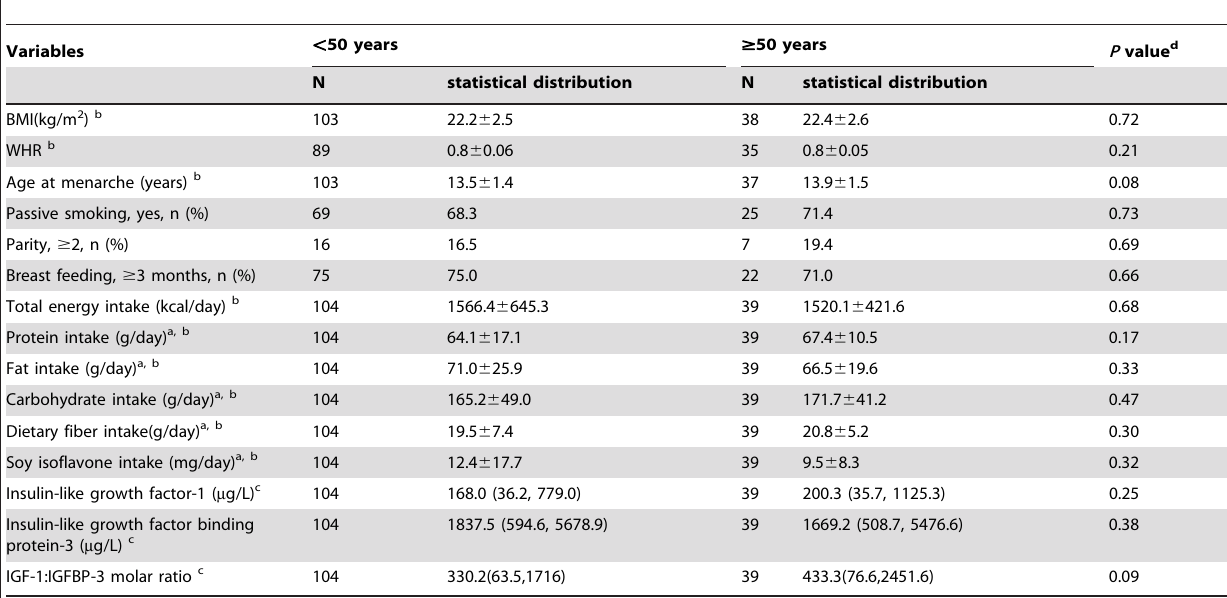
Table 1. Descriptive statistics of demographic, reproductive and insulin-like growth factors by age